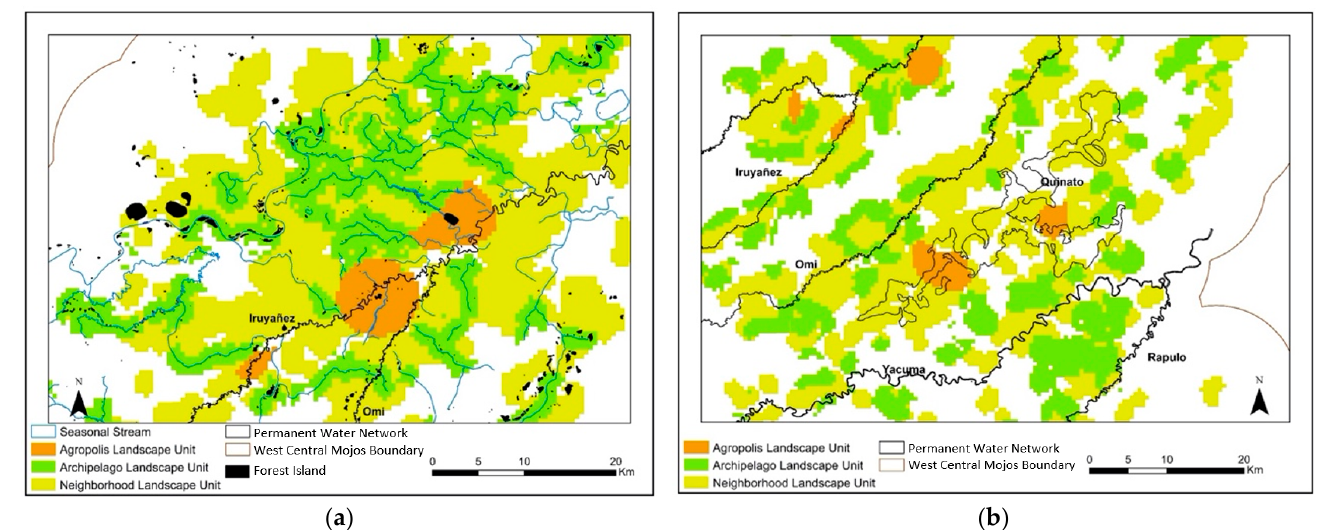
Figure 7. ( a ) The distribution of landscape types in the northern portion of the study area. Agropolises are spaced out along the Iruyañez river. ( b ) The distribution of landscape units in the southern portion of the study area. Agropolises are spaced out along the Quinato wetland. These are located between the rivers rather than along their